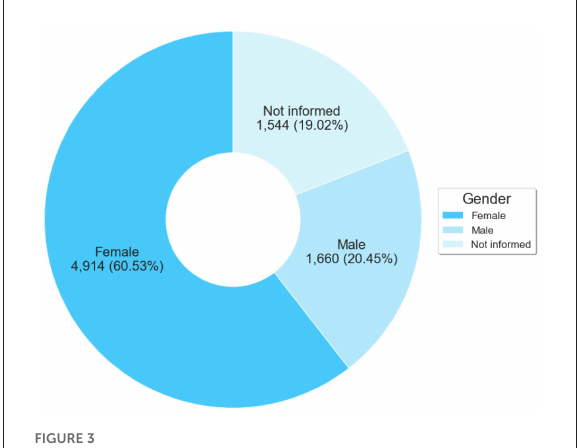
FIGURE3 Number of participants by Gender.